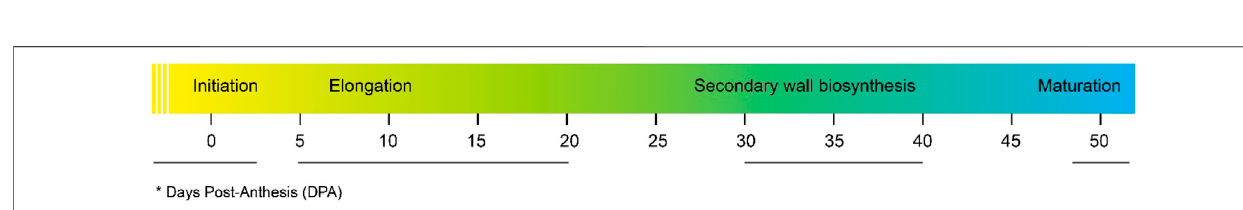
FIGURE 1 | Generalized structure of the cotton fi ber (M. Dochia and Z. Roskwitalski, 2012).